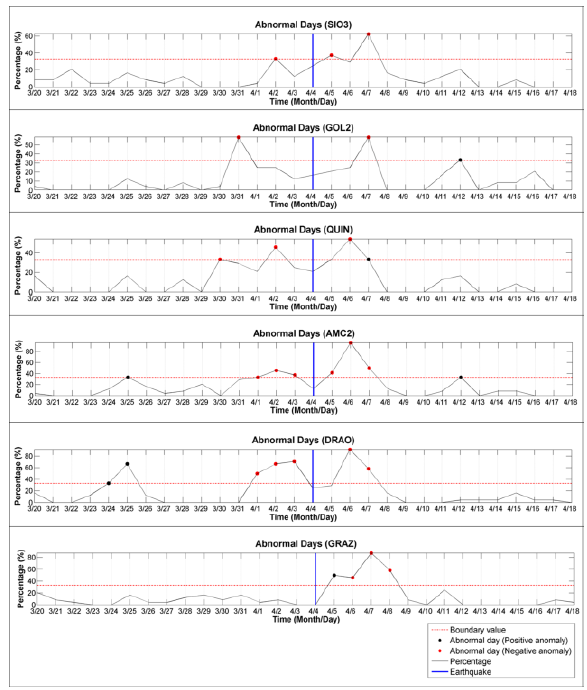
Figure 4. The percentage of the anomalous days during the period from March 20 to April 18, 2010. In Figure 4, blue vertical line show the earthquake occurrence moment; black line show percentages; horizontal dashed red line show boundary value; black dots show abnormal days with positive anomaly and red dots show abnormal days with negative anomaly.